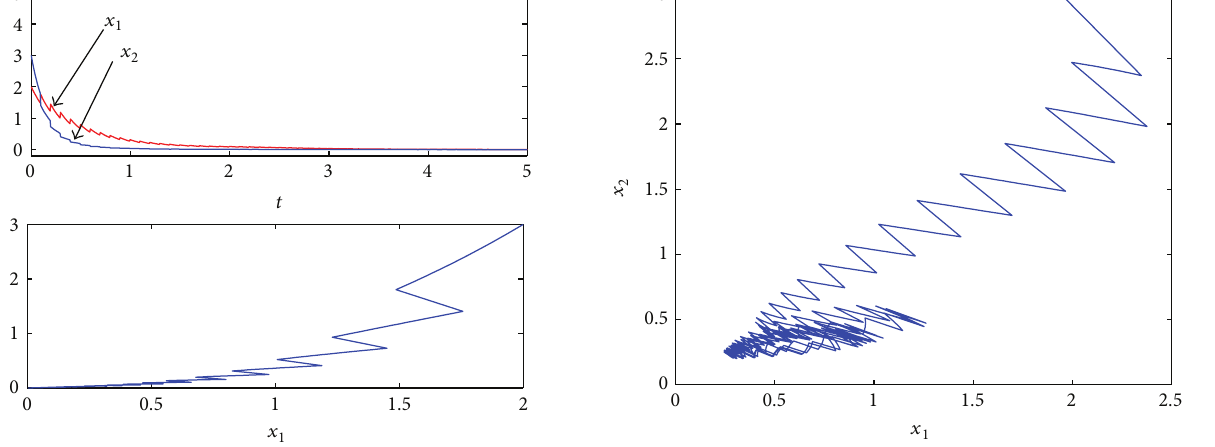
Figure 5: The phase of the permanence of species x .